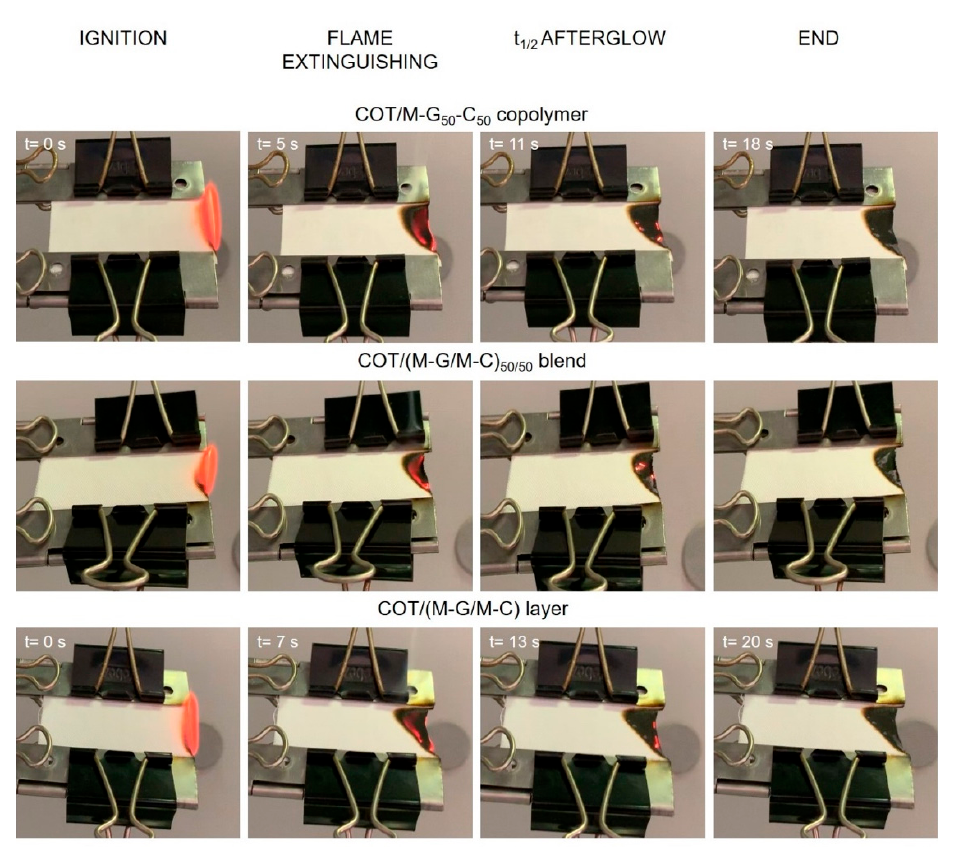
Figure 7. Snapshots of untreated, cotton fabrics treated with M–G 50 –C 50 copolymer (add-on: